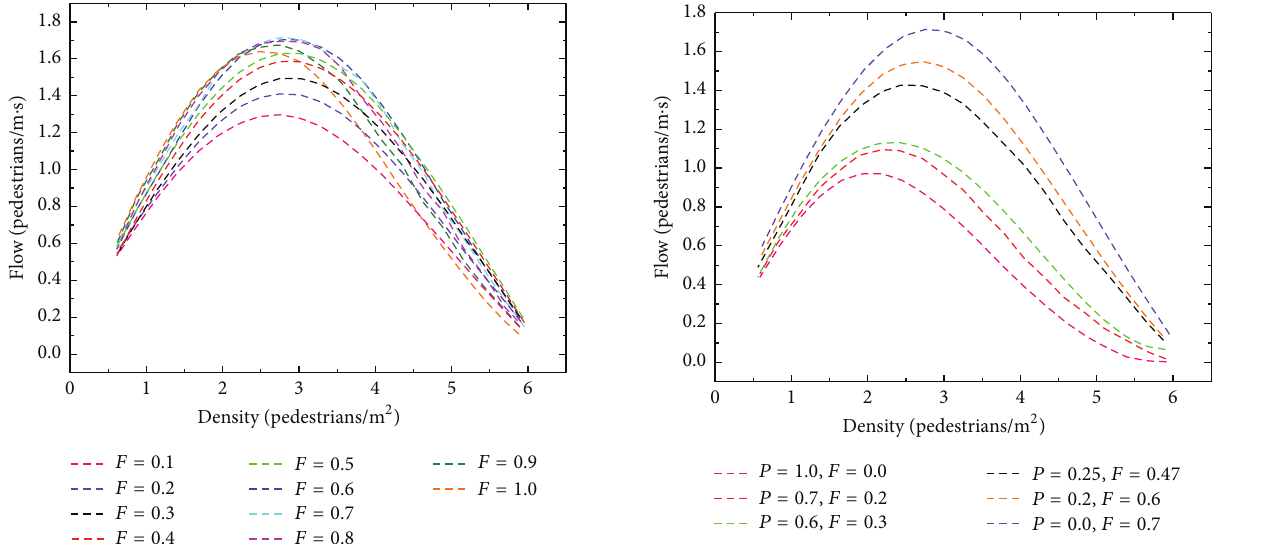
Figure 11: Fundamental diagrams of different heterogeneous parameter